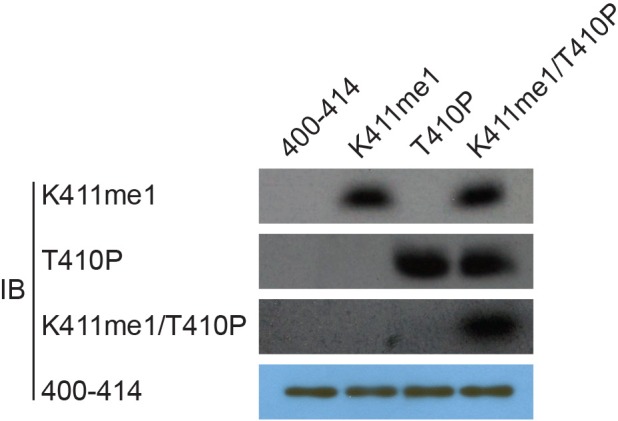
Validation of the antibodies’ specificity.To easily find whether methylation of RIOK1 occurred in cells, we prepared a modification-specific antibody, anti-RIOK1-K411me1, which specifically recognized monomethylated RIOK1-K411 but not the unmethylated peptide. This antibody also recognizes a pT410.K411me1 doubly modified peptide as efficiently as the K411me1 peptide. Conversely, the anti-pT410 antibody recognizes a pT410.K411me1 peptide as efficiently as the pT410 peptide. These specific antibodies are characterized. RIOK1 peptide substrates: 400–414 SKAMEIASQRTKEER(Lane 1), K411me SKAMEIASQRTKmeEER(Lane 2), T410p SKAMEIASQRTpKEER(Lane 3), K411me/T410p SKAMEIASQRTpKmeEER(Lane 4), p: phosphorylation; me: methylation.